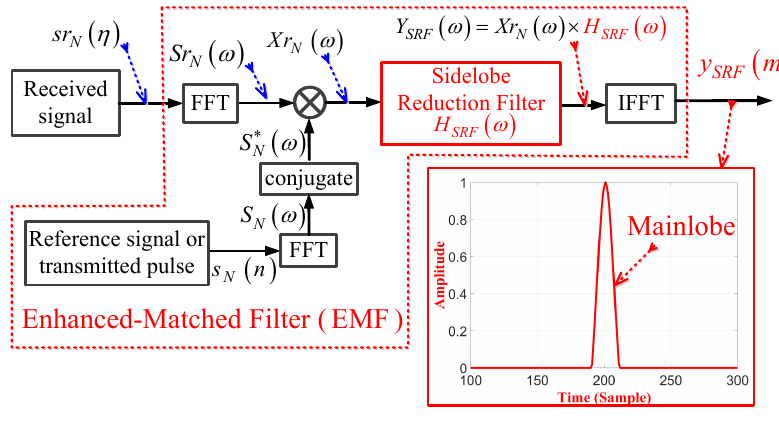
Figure 3. Block diagram of the proposed EMF. Figure 4 clarifies the concept of the SRF using the proposed EMF according to